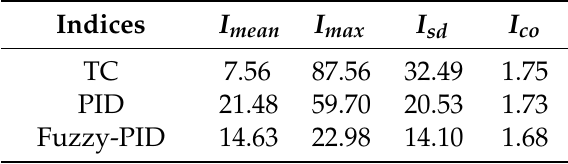
Table 5. Indices for the third set of